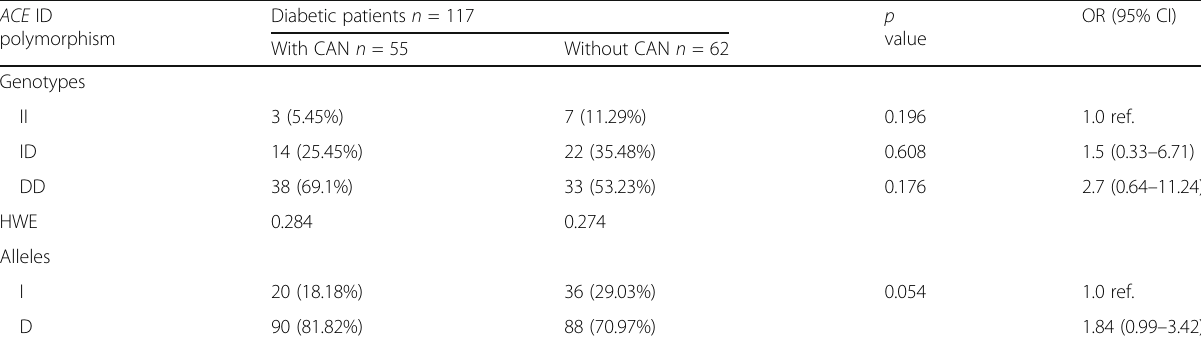
Table 4 Frequency of different genotypes and allele of ACE ID polymorphism in patients with and without cardiac autonomic